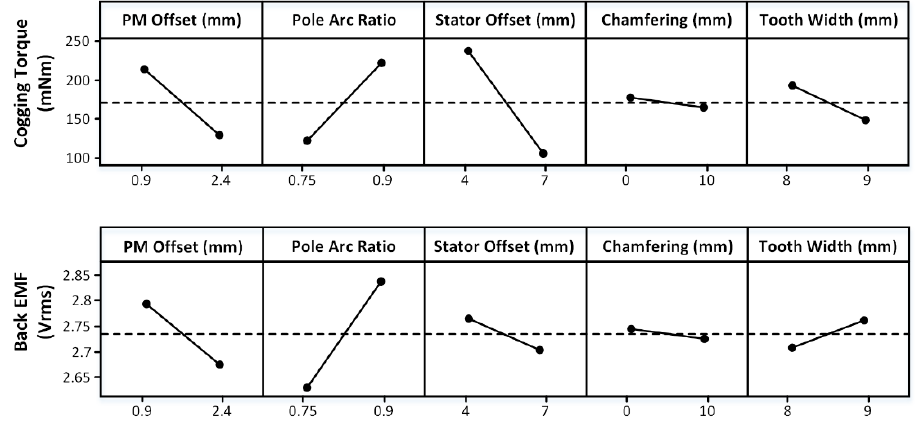
Figure 5. Effect of variables on the cogging torque and back EMF.